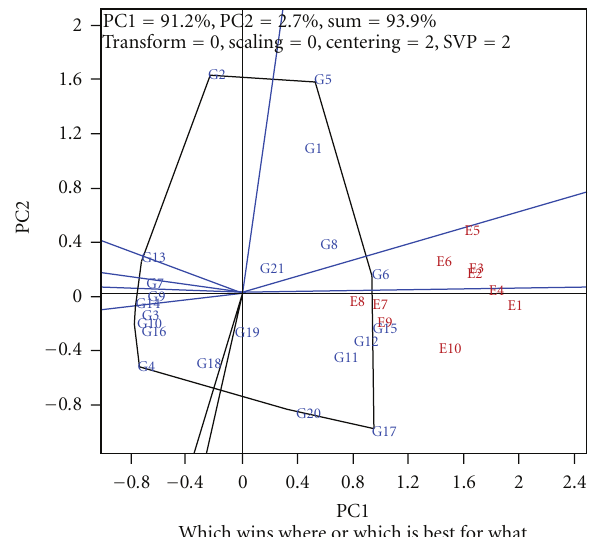
Figure 1: Megaenvironment defined by di ff erent winning yellow- fleshed cassava genotypes tested in 10 environments for the average severity score of CMD.